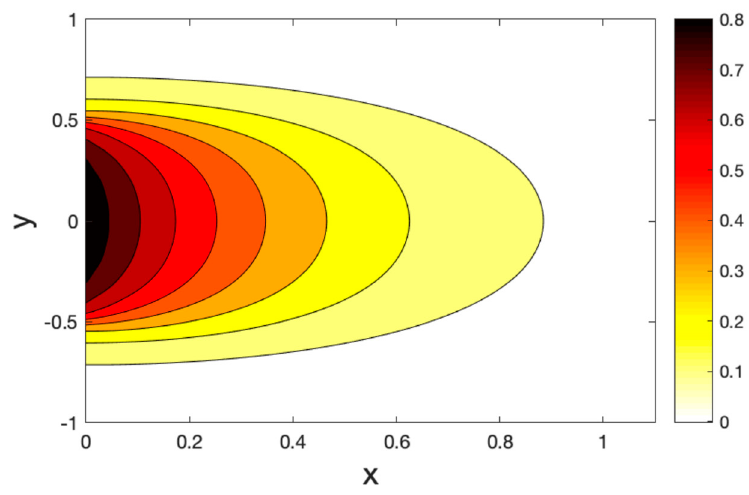
Figure 10. The variation of stress σ xy via x , with y = 0.5 under the three models.